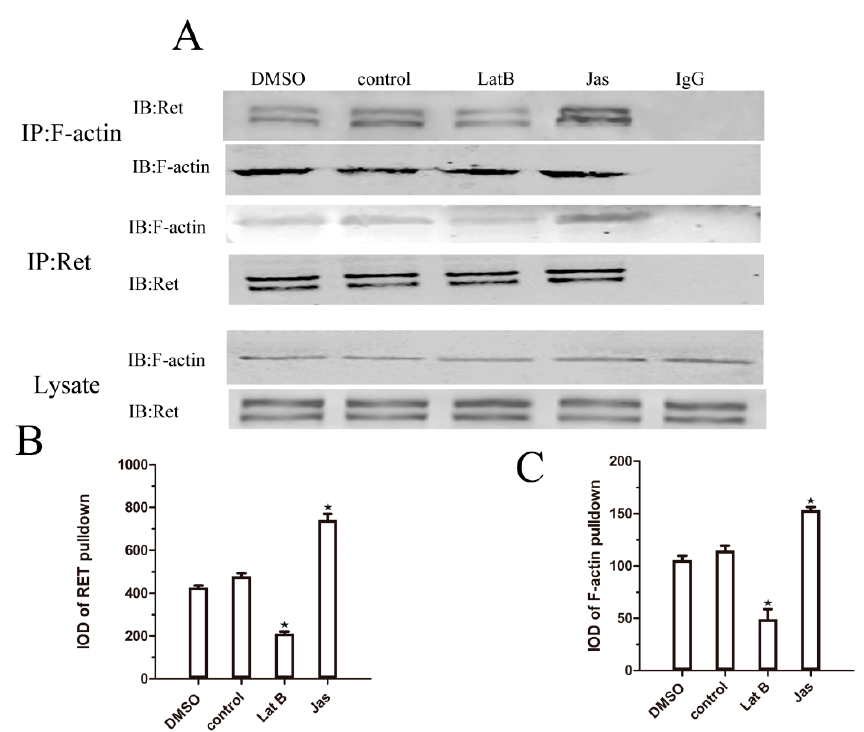
Figure 5. GDNF-induced Ret–F-actin association is impaired by Lat B or promoted by Jas. ( A ) The MN9D cells were divided into the following four groups: in the control group, the cells were cultured under normal conditions and treated with GDNF for 30 min; in the dimethylsulfoxide (DMSO)group (solvent group), the cells were pretreated with 1 mM DMSO for 30 min and then treated with GDNF for 30 min; in the Lat B group, the cells were pretreated with 10 μ M Lat B for 30 min and then treated with GDNF for 30 min; and in the Jas group, the cells were pretreated with 50 nM Jas for 30 min and then treated with GDNF for 30 min. Lysates obtained from MN9D cells were immunoprecipitated with anti-Ret, anti-F-actin, and normal rabbit IgG. As a loading control, the amount of Ret and F-actin present in the whole lysates is shown at the bottom; ( B ) The quantitative analysis of IOD of co-immunoprecipitated Ret from the experiments is depicted in ( B ); ( C ) The quantitative analysis of IOD of co-immunoprecipitated F-actin from the experiments is depicted in ( C ). The data were represented as means ± SEM of three independent experiments. ★ p < 0.05 vs. control.